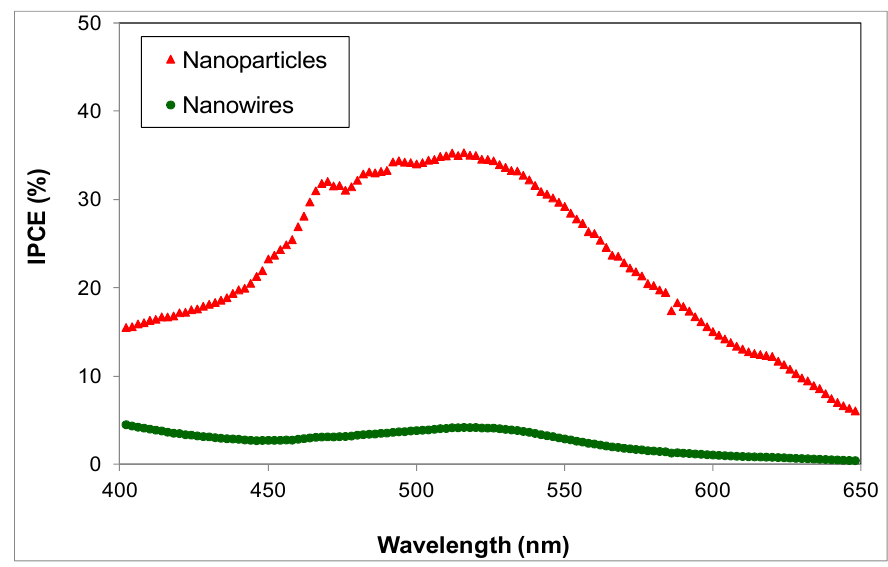
Figure 4. IPCE values of nanoparticle-based and nanowire-based DSSCs as a function of wavelength.